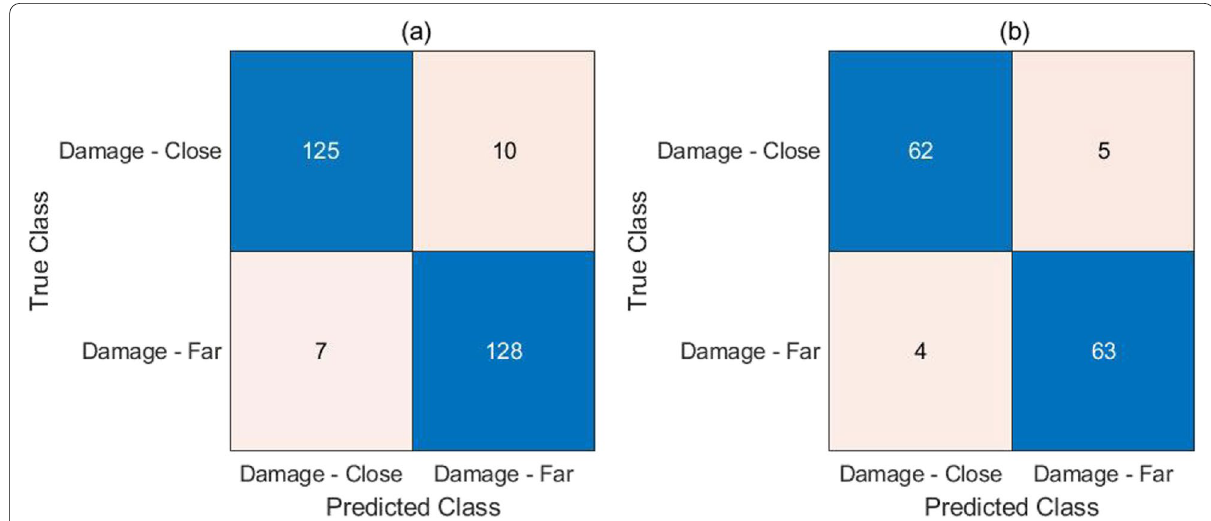
Fig. 16 Confusion matrices for ( a ) validation and ( b ) testing data of the wooden beam